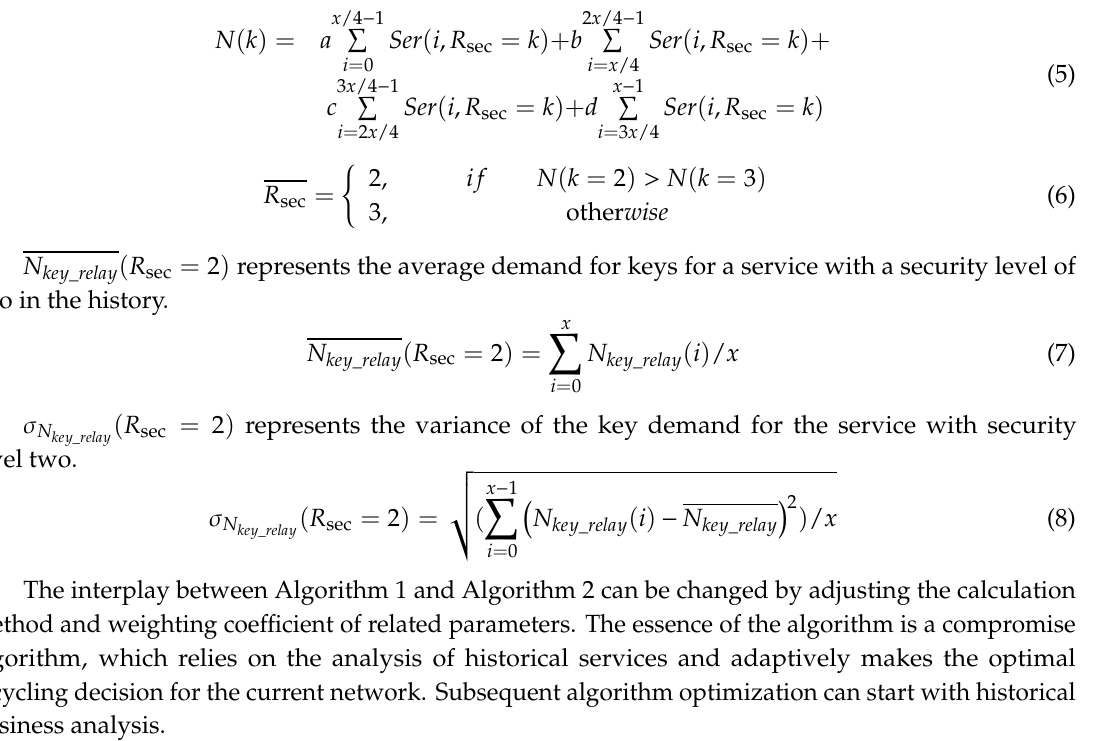
Table 2. Characteristic of Service.